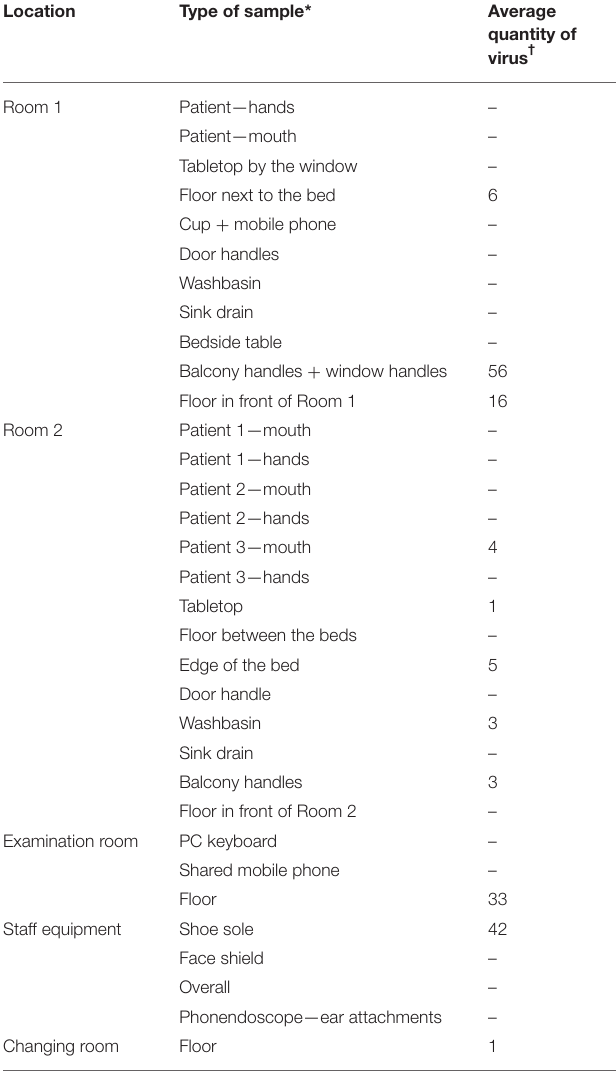
TABLE 2 | Description of the samples collected at the COVID-19 unit.